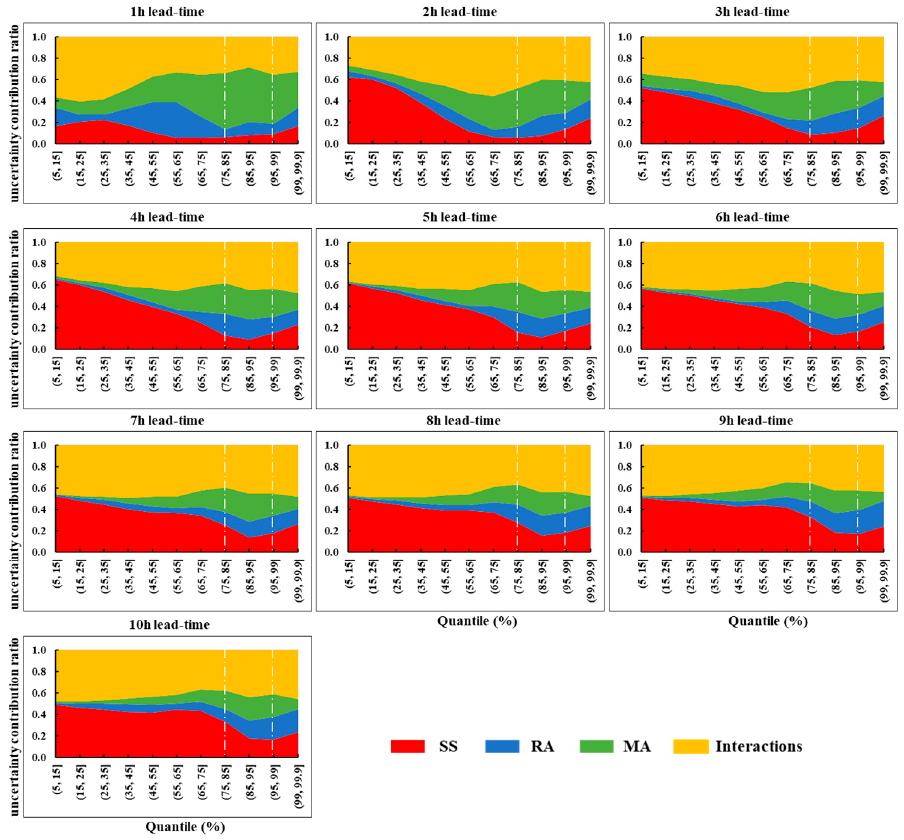
ff erent discharge